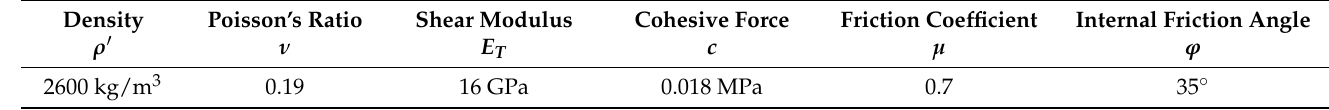
Table 3. Parameters for